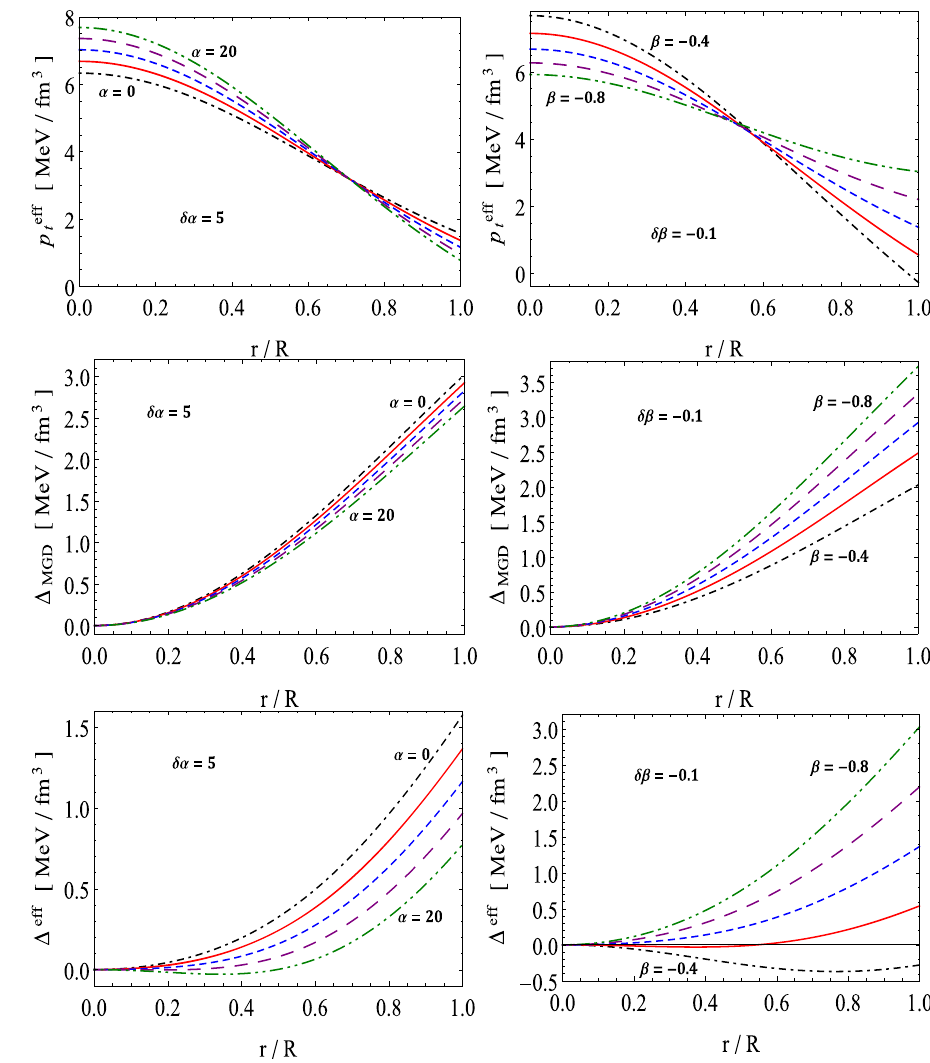
Fig. 4 Variation of effective tangential pressure ( p eff t ) versus radial coordinate r / R . The left figure is plotted for fixed β = − 0 . 6 with different α while right figure for fixed α = 5 with different β